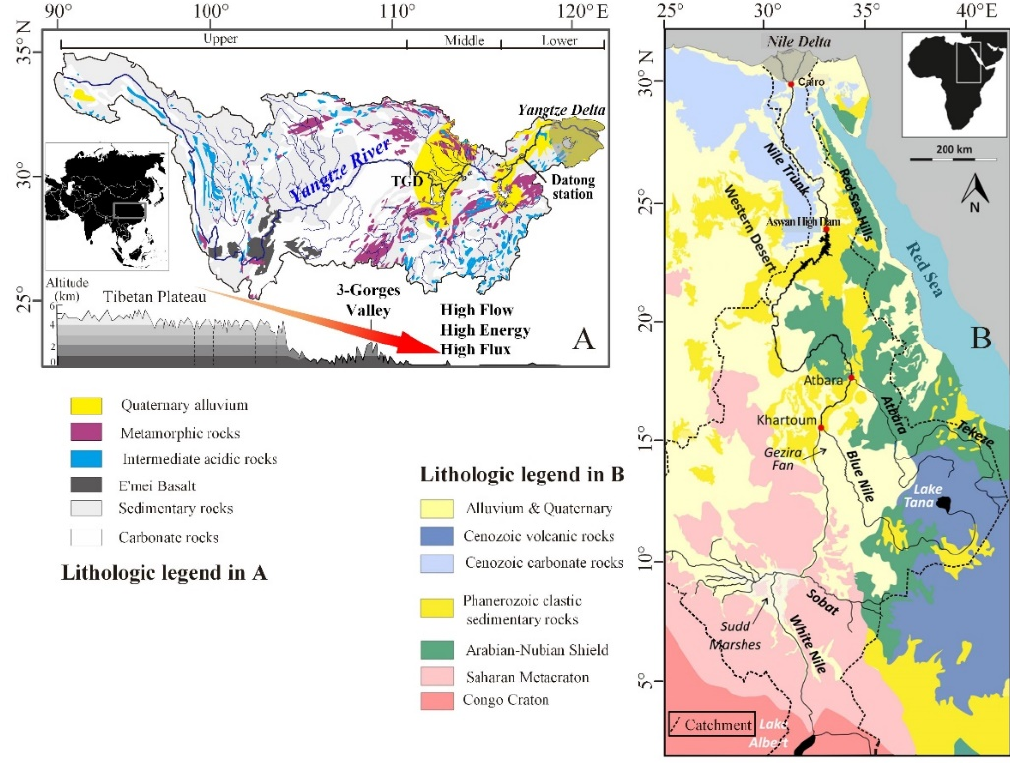
Figure 1. ( A ) The Yangtze River basin, showing the location of the Three Gorges Dam (TGD) and Datong hydro-gauging station. ( B ) The Nile River basin, showing the location of the Aswan High Dam (AHD). The lithology of both river basins is modified from [6,7].